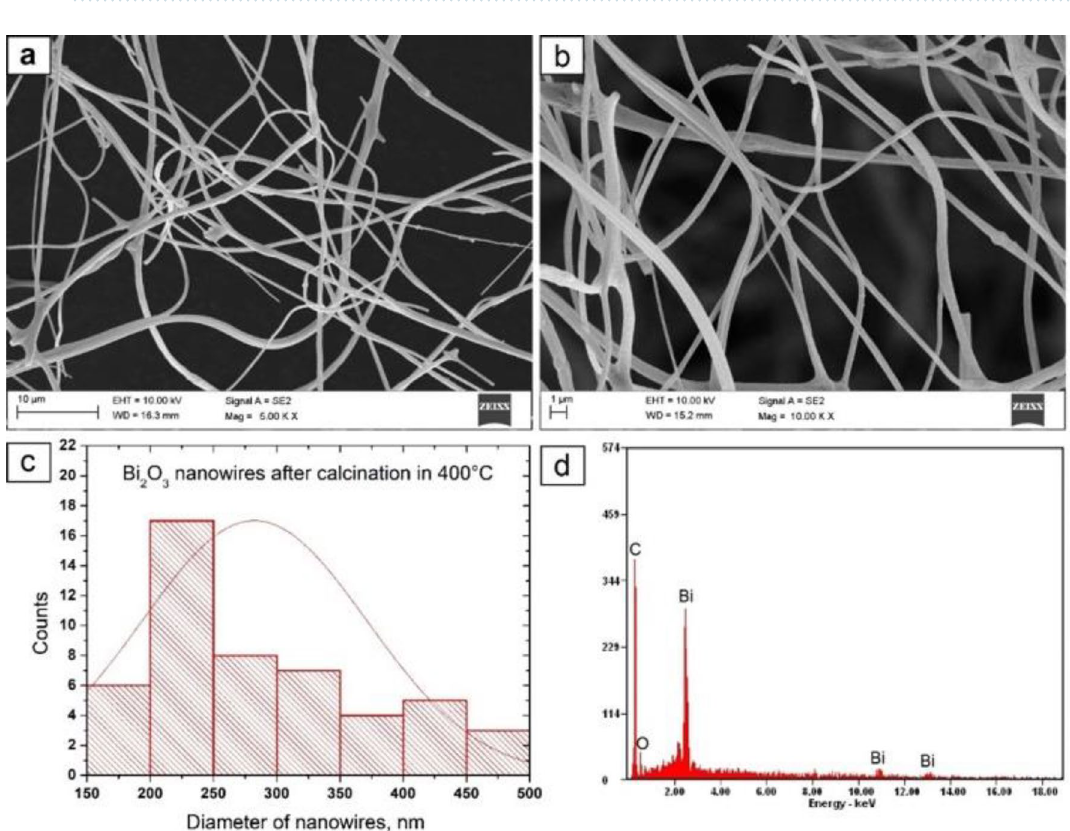
Figure 5. SEM image of the topography on the surface of obtained nanowires after calcination the PAN/ Bi 2 O 3 fibrous composite mats in 400 °C, magnification 5 000 x ( a ) and 10 000 x ( b ), histograms presenting the distribution of the diameter of randomly selected nanowires ( c ), EDS spectra (peak of C derive from the substrate on which nanowires were deposited) from the entire area shown in the SEM images ( d